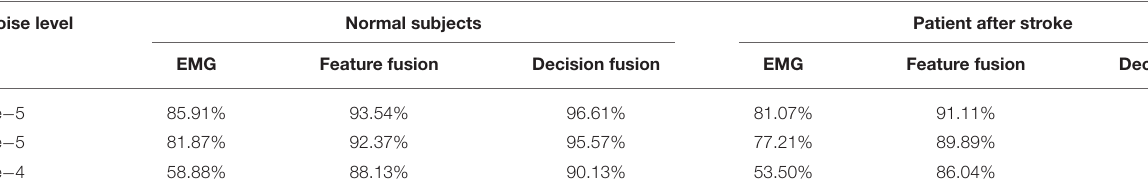
TABLE 2 | Test accuracy of classifiers when given different levels of noise. Noise